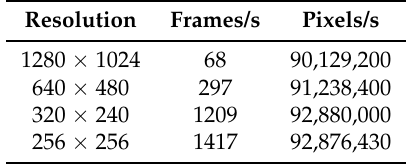
Table 3. Processing speed for different image resolutions, operating frequency = 50 MHz.